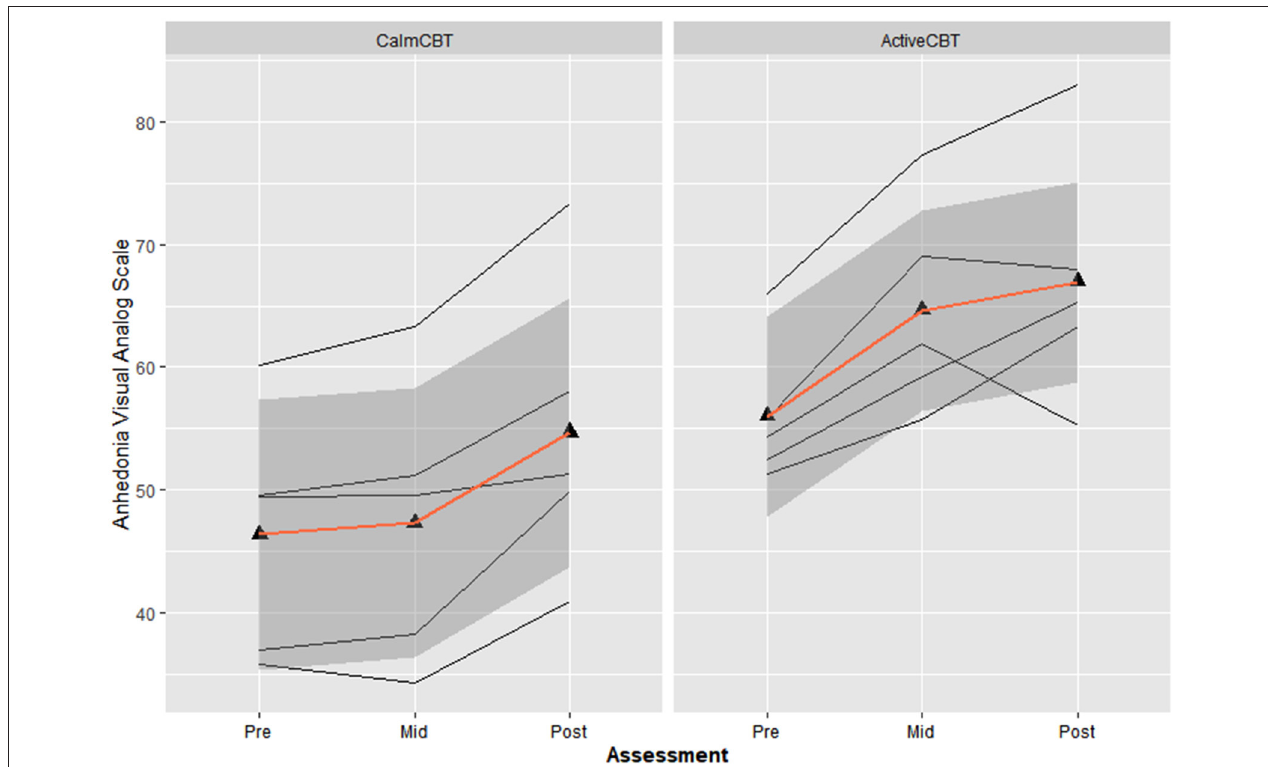
FIGURE 2 | Changes in anhedonia visual analog scale (VAS) within sessions by group. Average changes across all 8 visits in Anhedonia VAS ratings immediately before the Active or Calm condition (i.e., Pre-Condition), immediately after the condition (i.e., Post-Condition) and immediately after the 50-min CBT session (i.e., Post-Therapy). Higher Anhedonia VAS ratings indicate lower levels of